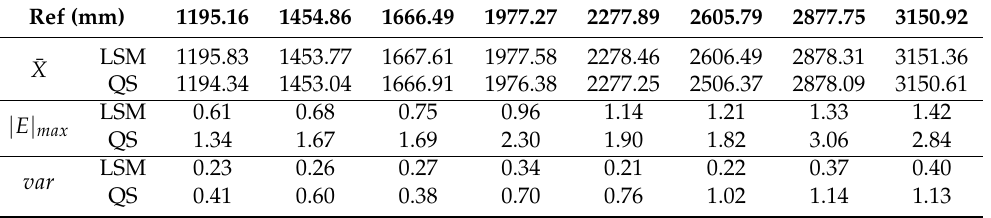
Table 2. The statistics of distance measurements. QS: quadrature